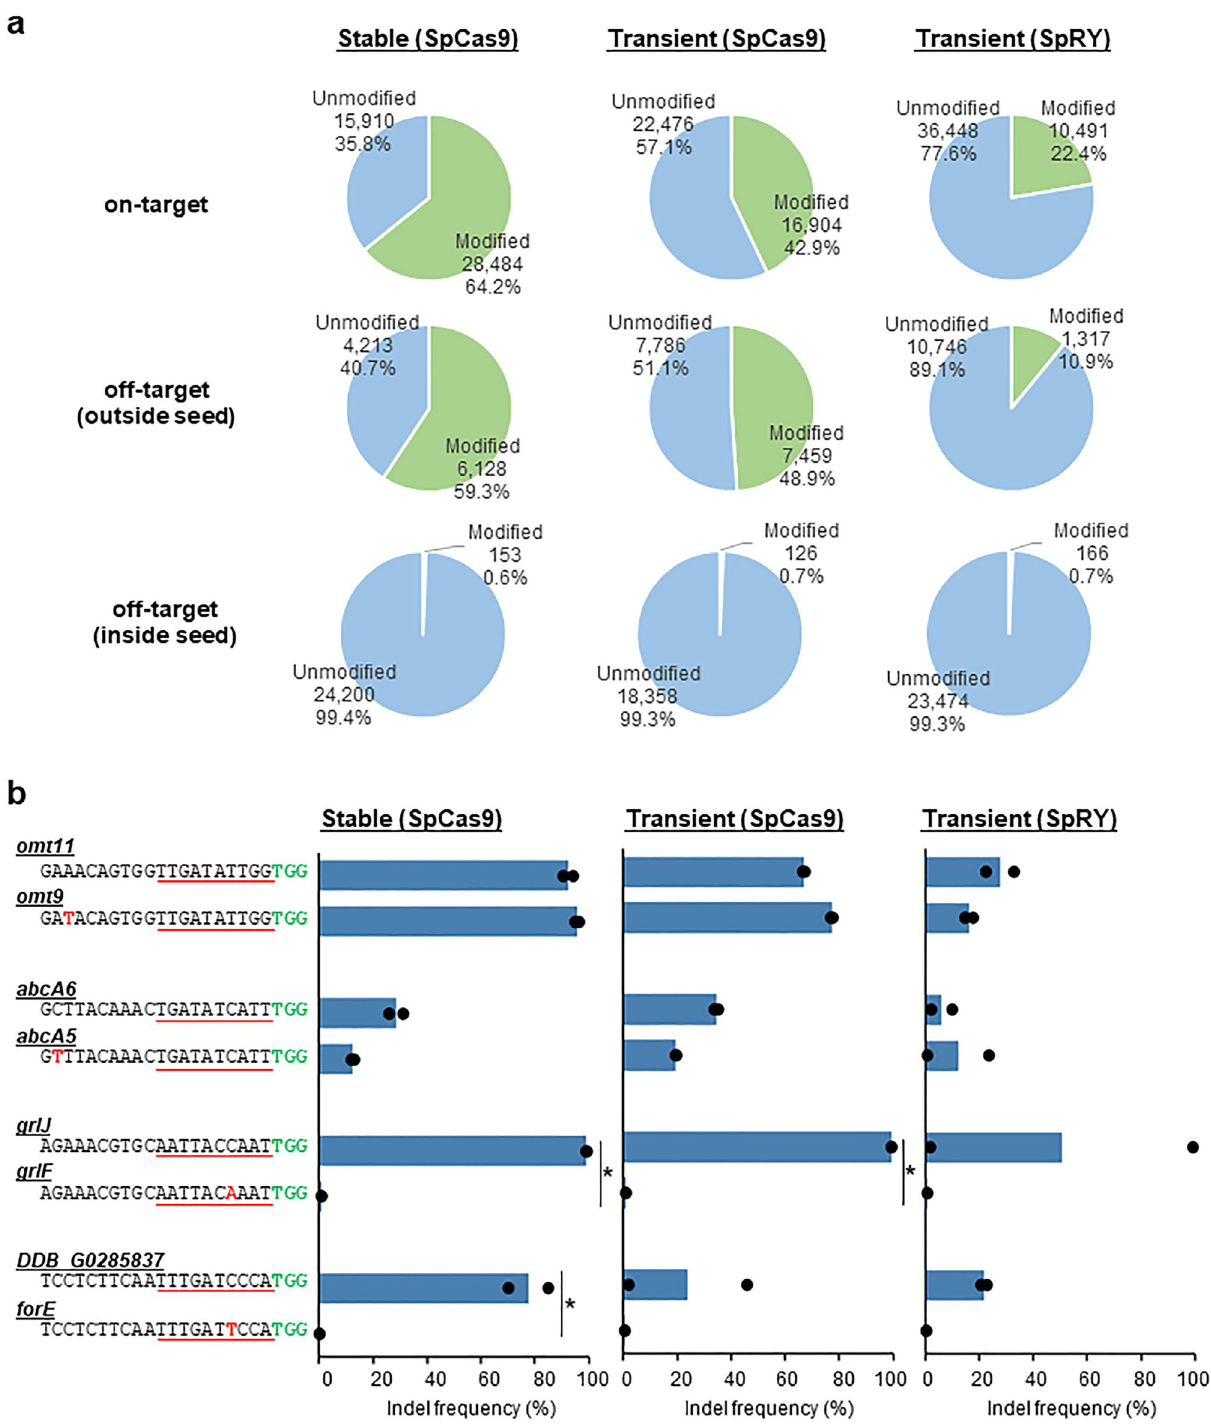
Figure 1. Detection of off-target mutations induced by CRISPR/Cas9 stable and transient expression vectors. ( a ) Percentage of on-target and off-target via three CRISPR vectors. The numbers and percentages of modified and unmodified loci. Outside seed and inside seed represent the presence of mismatches outside and inside the seed region of the target sequence, respectively. ( b ) Indel frequency for each on-target and off-target sequence. Mismatch sequences within off-targets and PAM sequences are presented in red and green letters, respectively. Seed sequence is underlined in red. Data represent two biological repeats and individual data points are shown. p -values were calculated using a one-way Welch two-sample t -test (* p <